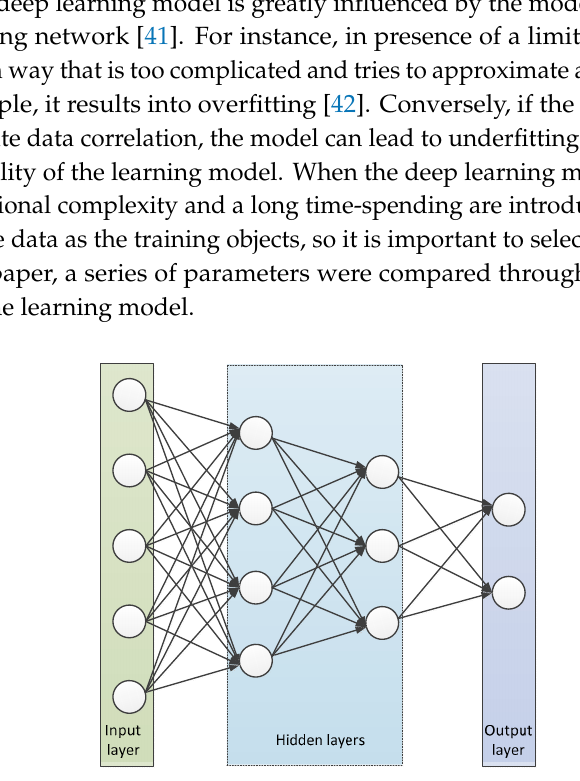
Figure 2. Learning structure.